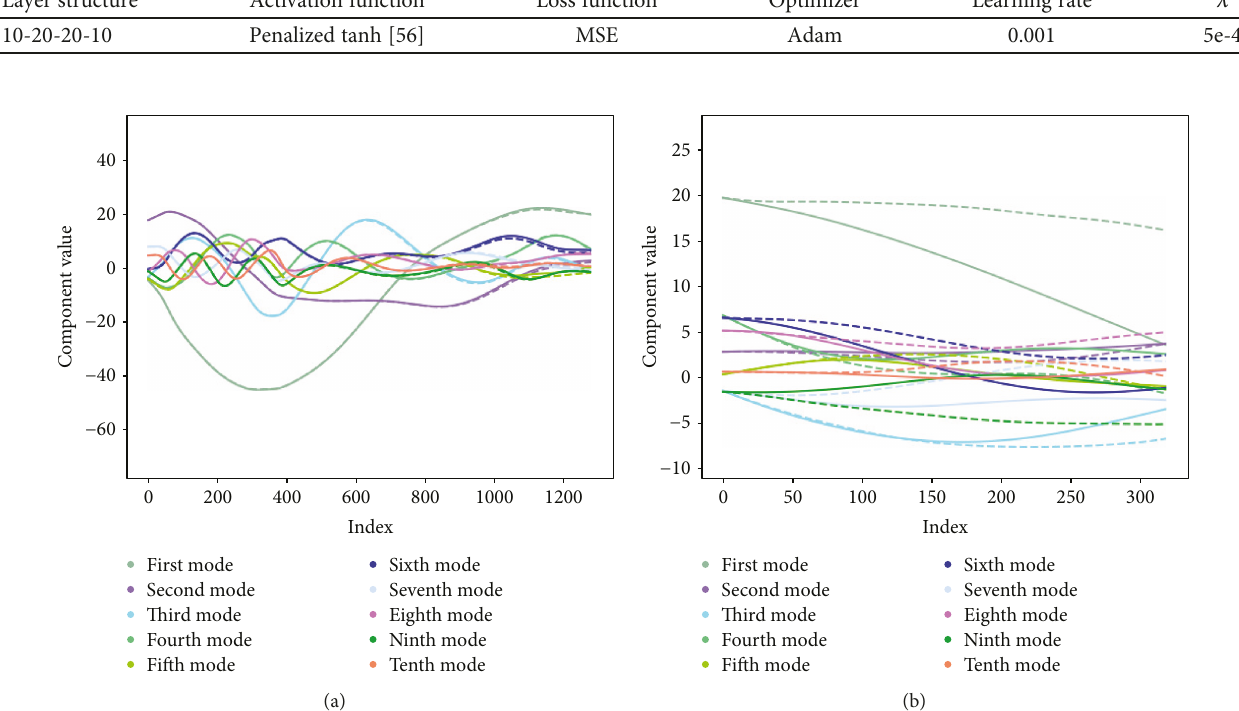
Table 4: Hyperparameter con fi guration of the Jacobian regularized model for buoyant mixing fl ow. Layer structure